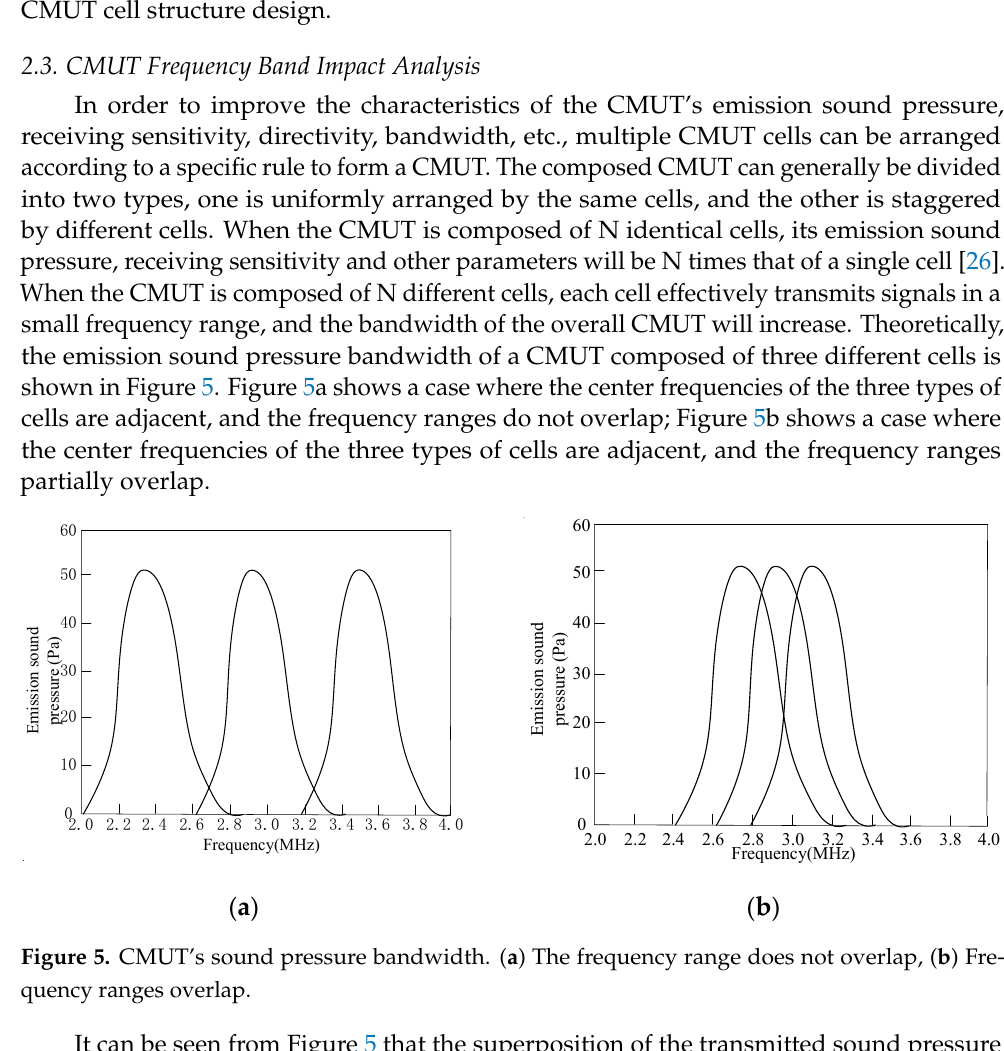
Figure 6. Hybrid cell structure CMUT model diagram. 2.3.1. Finite Element Simulation Analysis of Wideband CMUT In this section, a CMUT structure composed of three kinds of cells with vibrating membrane sizes of 59 μ m–2.6 μ m, 60 μ m–2.6 μ m, and 61 μ m–2.6 μ m is established. The resonance frequencies of the three types of cells in the air are 3.13 MHz, 3.02 MHz, and 2.93 MHz, respectively. The structural parameters of them are shown in Table 3, the num- ber of cells is 9, and the spacing is 5 μ m. Through COMSOL finite element simulation